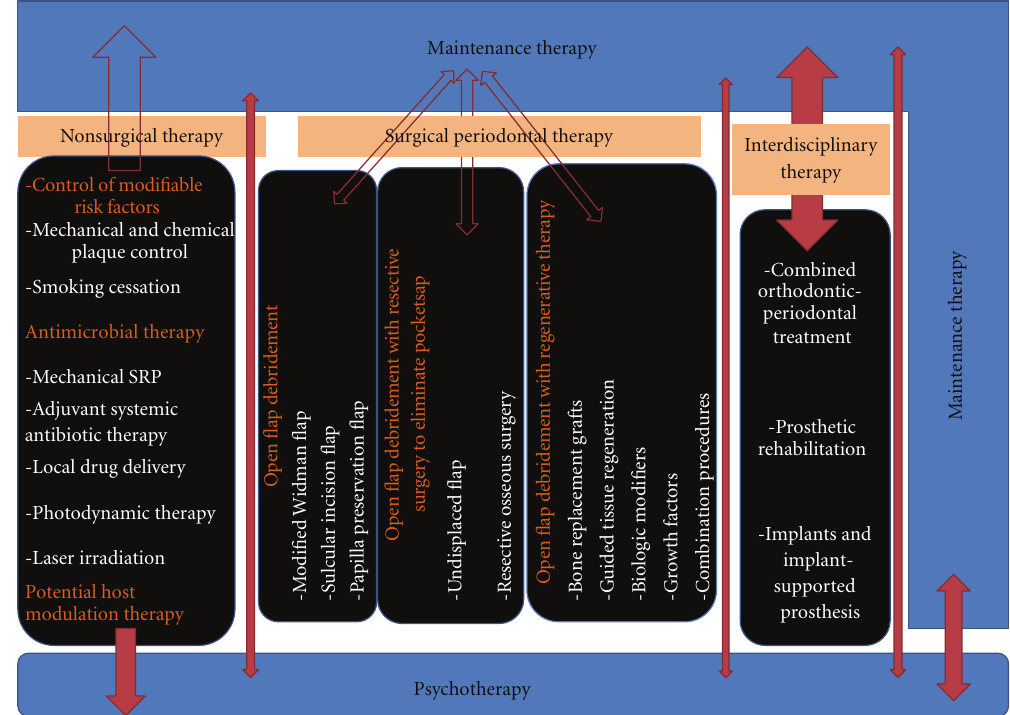
Figure 14: The treatment commences with a nonsurgical phase following which psychotherapy sessions are started for the needy patients, and patients are put on maintenance therapy/supportive periodontal therapy thereafter. While the patient is on maintenance therapy, one or more of the 3 modalities of surgical periodontal therapy can be performed depending upon the indication and once periodontium has been stabilized, an interdisciplinary treatment for the restoration of lost teeth and correction of cosmetic problems is completed following which the patient continues for a “lifelong” maintenance